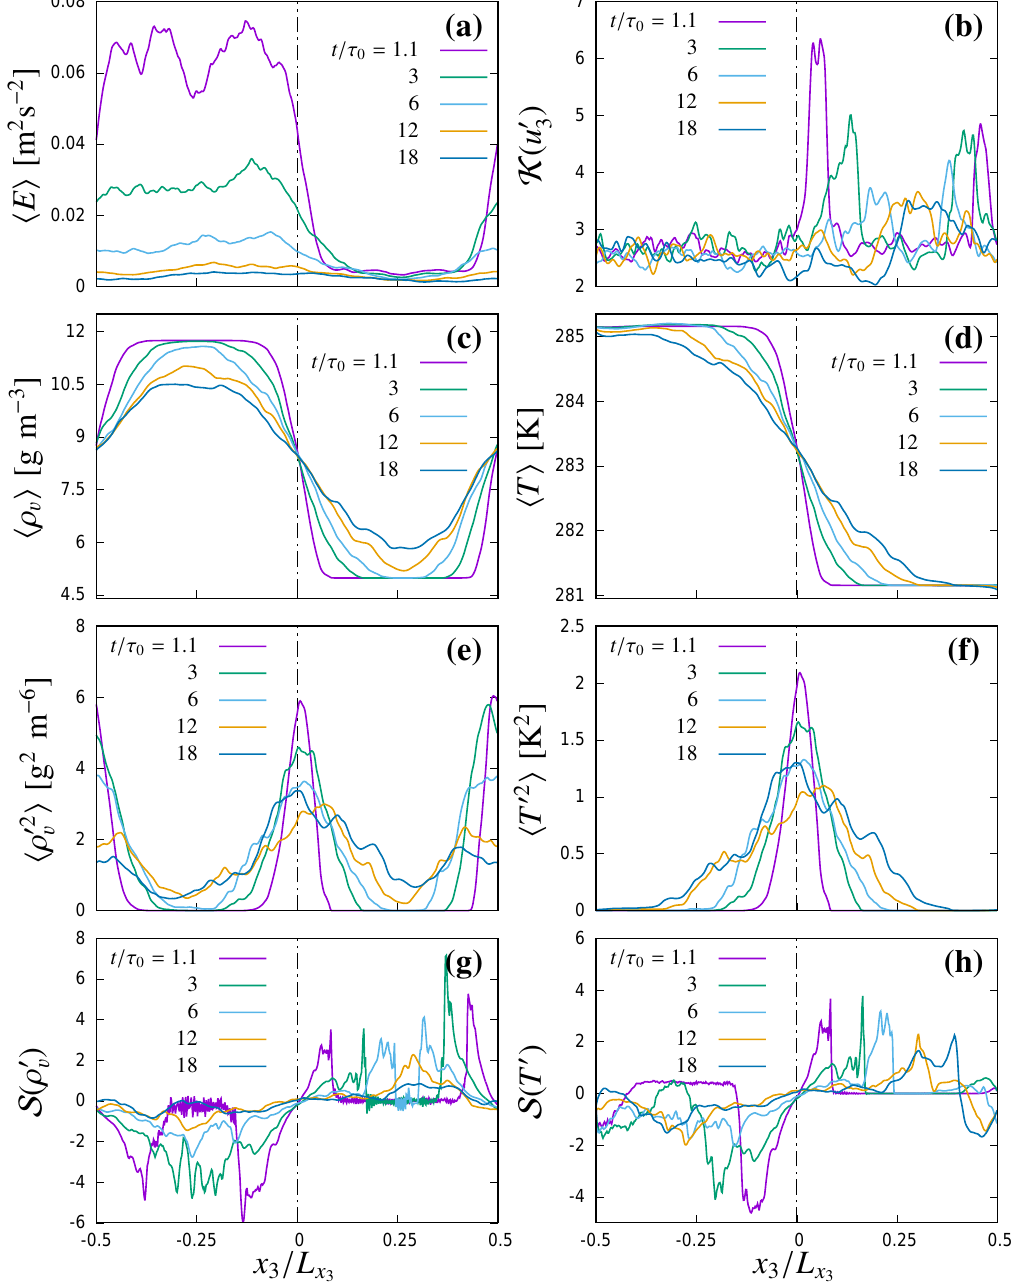
E ; ( b ) kurtosis of vertical velocity fluctuations (cid:104) (cid:105) T (cid:48) 2 ; ( g ) skewness of water vapour (cid:104) (cid:105)